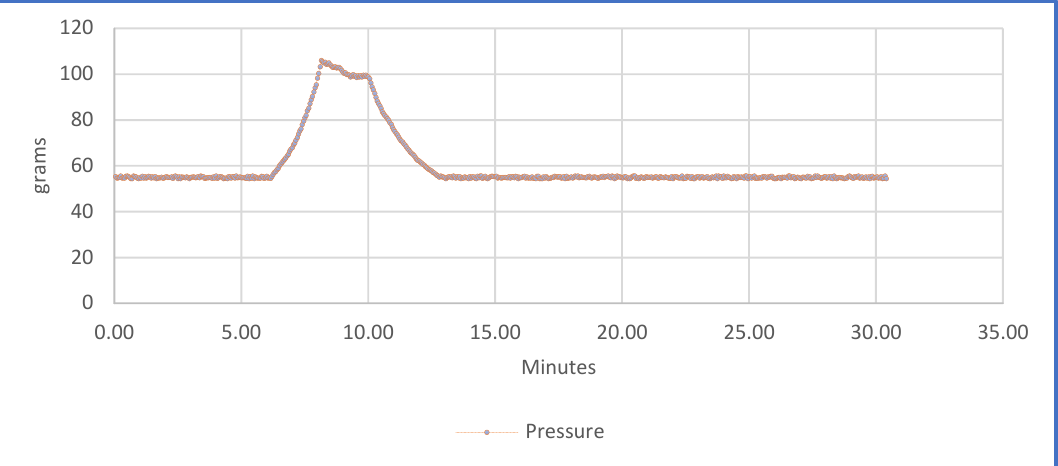
Figure 18. Pressure graph.